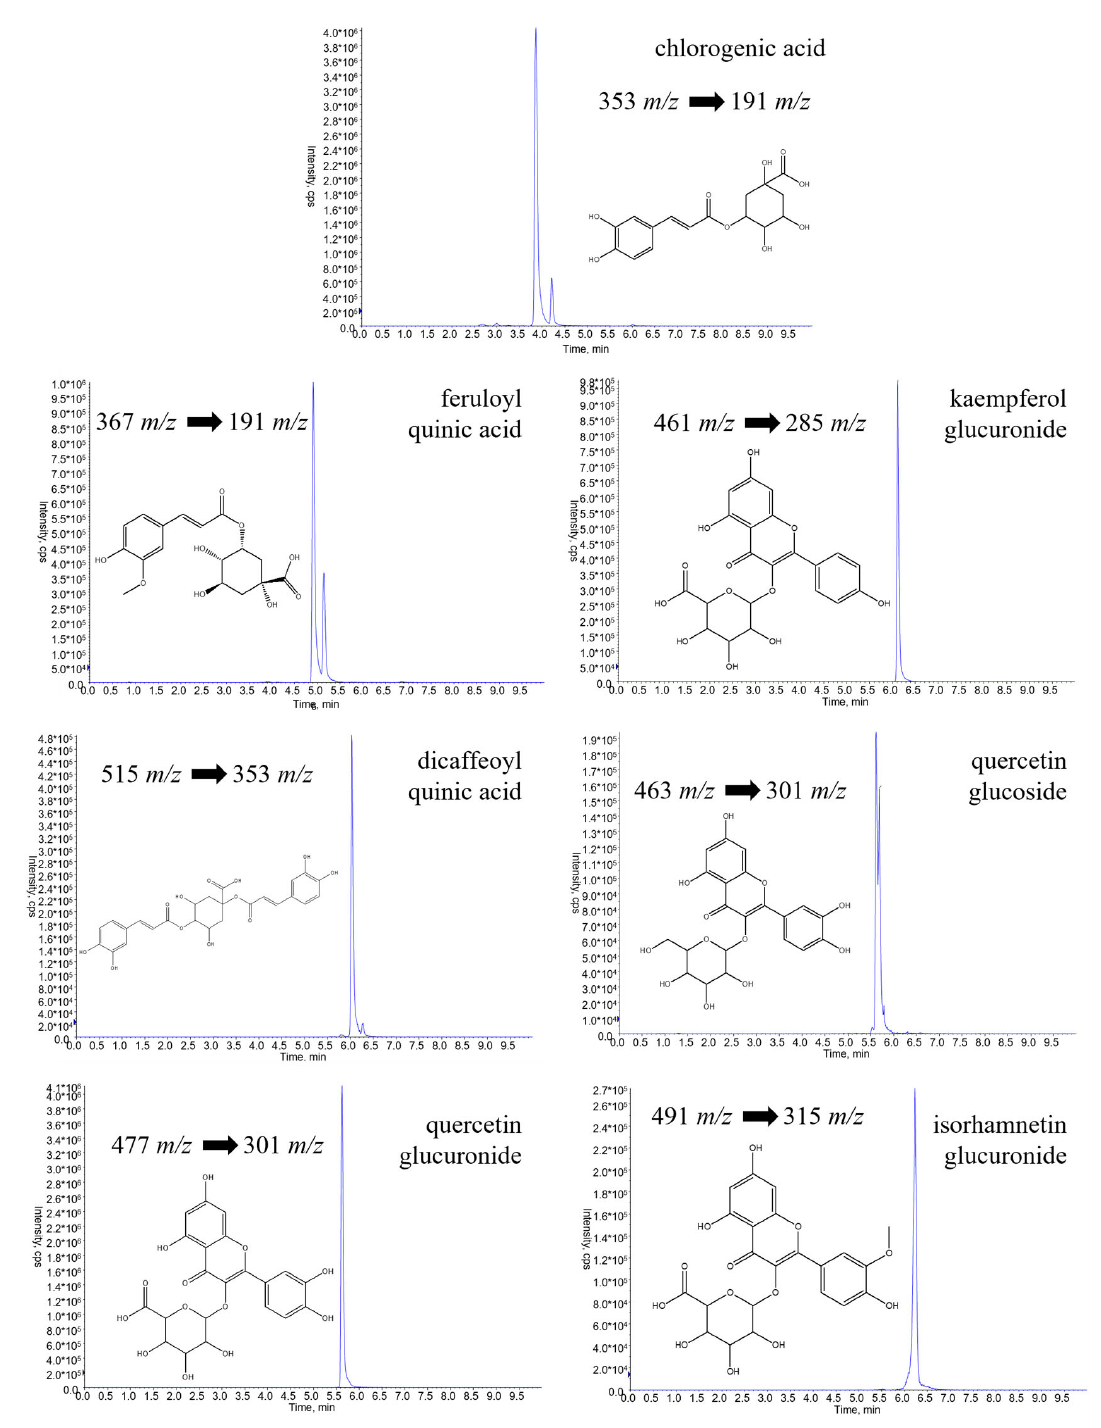
Figure 1. Q1/Q3 mass transitions for chlorogenic acid, quercetin glucoside, quercetin glucuronide, kaempferol glucuronide, isorhamnetin glucuronide, feruloylquinic acid, and dicaffeoylquinic acid obtained by UHPLC-ESI-QTRAP-MS/MS analysis and selected for MRM analysis of a standard mix.